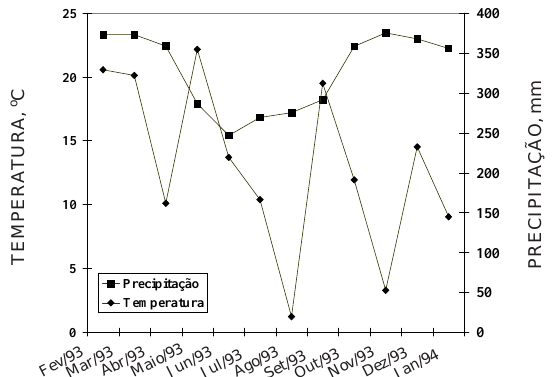
Figura 1. Temperatura média mensal e precipitação no período de fevereiro de 1993 a janeiro de